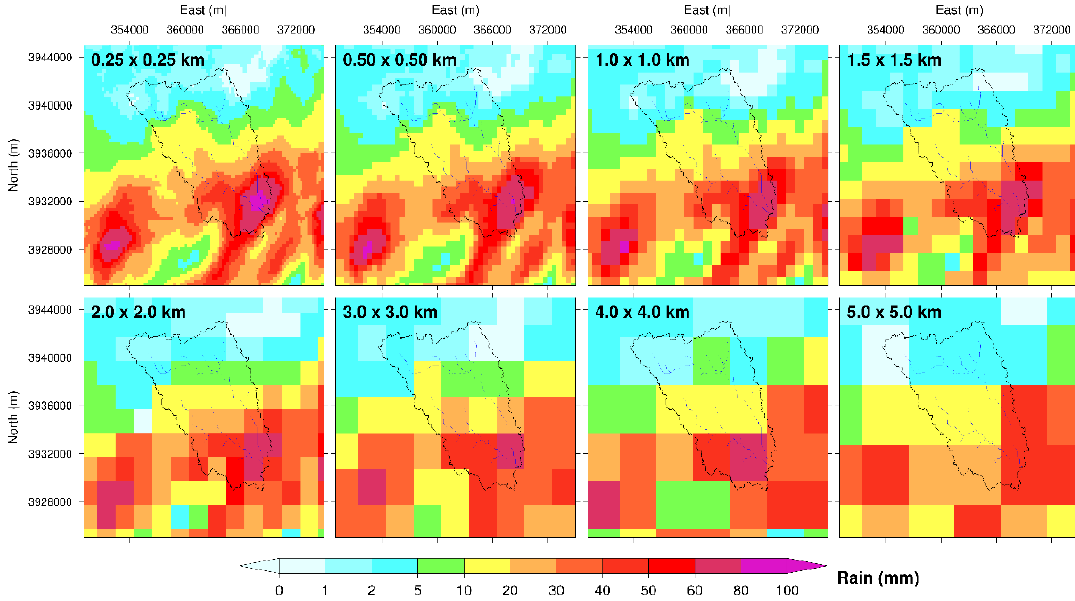
Figure 7. 2-h accumulated rainfall at different spatial resolutions over the Tsurumi River Basin and its periphery at 02:00–04:00 UTC on 8 August 2012.